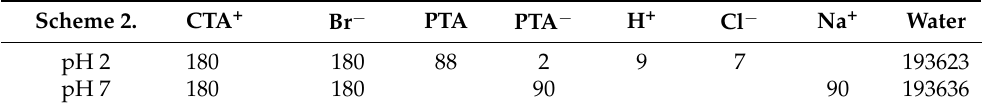
Table 1. Simulated systems: numbers of each component in the different systems. Scheme 2.